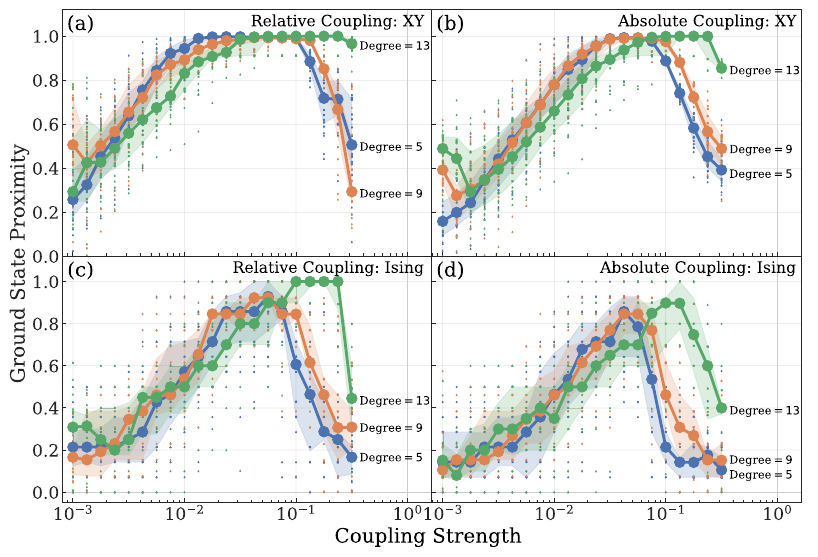
Figure 3: Optimal amplitude range study for relative and absolute coupling models on the unweighted MaxCut problems of size N (cid:1) 16 with degrees 5, 9, and 13. The median accuracy is shown for the XY Hamiltonian in (a – b) and the Ising Hamiltonian in (c – d). Both models are simulated with Eqs. (7) and (8) for 20 random initial conditions per each coupling strength. Shading indicates 25th and 75th percentile range of